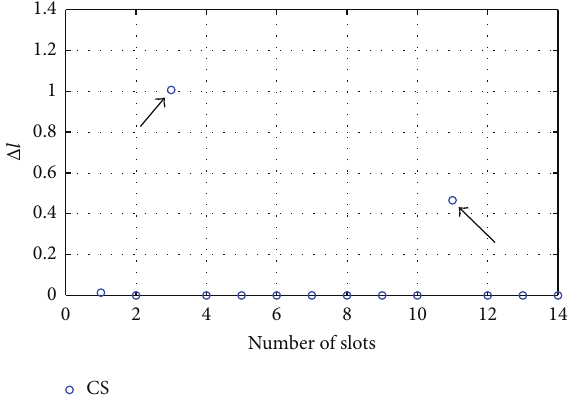
Figure 12: ℓ 1 minization: the difference of excitations in the absence and the presence of failures (slots 3 and 11